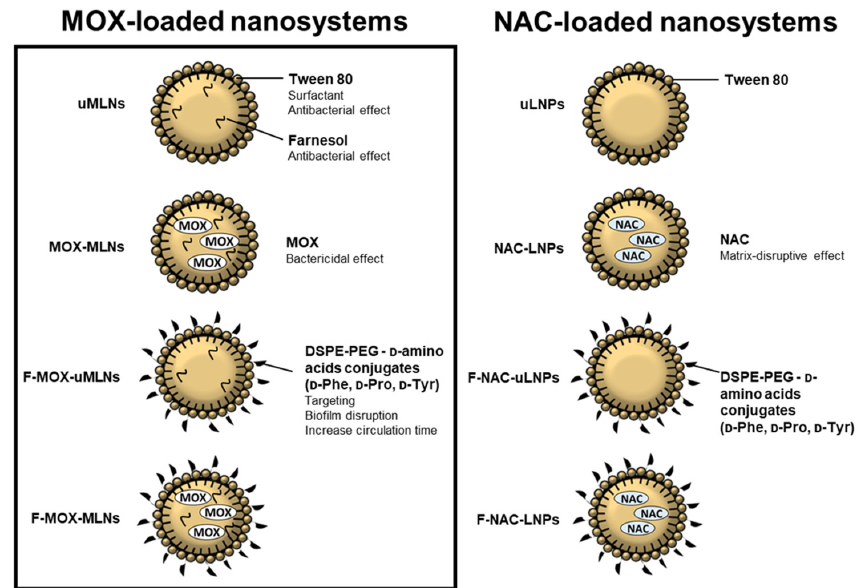
Figure 1. Schematic overview of the antibacterial and antibiofilm components of the nanosystems used for the proposed combinatory strategy. MOX-loaded MLNs were produced by an adapted protocol previously described by Cavalcanti et al. (2017) [23], while NAC-loaded nanosystems were produced by the double emulsion method [10]. The MLNs were composed of cetyl palmitate (solid lipid), Miglyol 812 (liquid lipid), farnesol, and the surfactants Tween 80 and Span 80. The LNPs were composed of cetyl palmitate and Tween 80. The surface of the nanoparticles was functionalized with DSPE-PEG- ᴅ -amino acid conjugates.